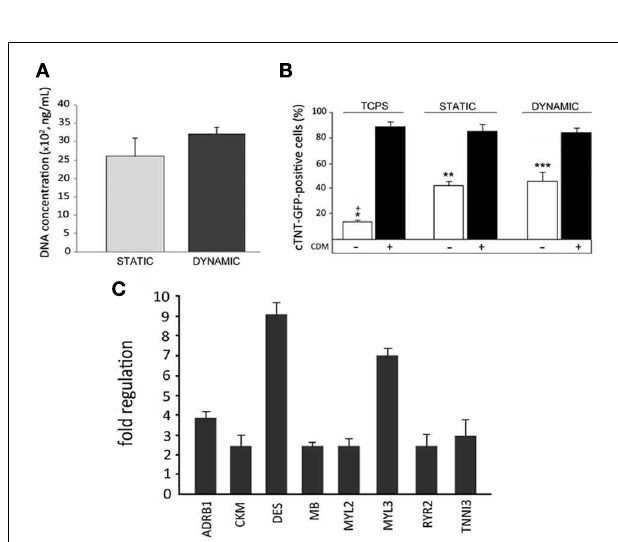
FIGURE 5 | Dynamic culture conditions induce a superior cardiac commitment in human cardiac progenitors (hCMPCs). Dynamic culture conditions provide a higher, although not significant, increase in scaffold cell colonization as compared to static conditions (A) . Percentage of differentiated cTNT-GFP CMPCs stimulated with cardiogenic differentiation medium (CDM) and cultured on TCPS and scaffolds, under dynamic, or static conditions, as evidenced by FACS analysis (B) ( ∗ , ∗∗ , ∗∗∗ P < 0 . 05 between hCMPC basal medium and CDM). Importantly, a significant commitment can be induced, equivalently, by 3D culture itself in both static and dynamic conditions compared to TCPS ( + P < 0 . 05 between TCPS and 3D scaffolds). Nonetheless, quantitative PCR analysis demonstrates the up-regulation of few cardiac-specific genes in hCMPCs (C) cultured in dynamic conditions, as compared to its static control (for a complete list of genes analyzed please refer to Supplementary Table 1; among the genes analyzed, those not showing a consistent and significant difference in the expression as compared to their respective controls, are not